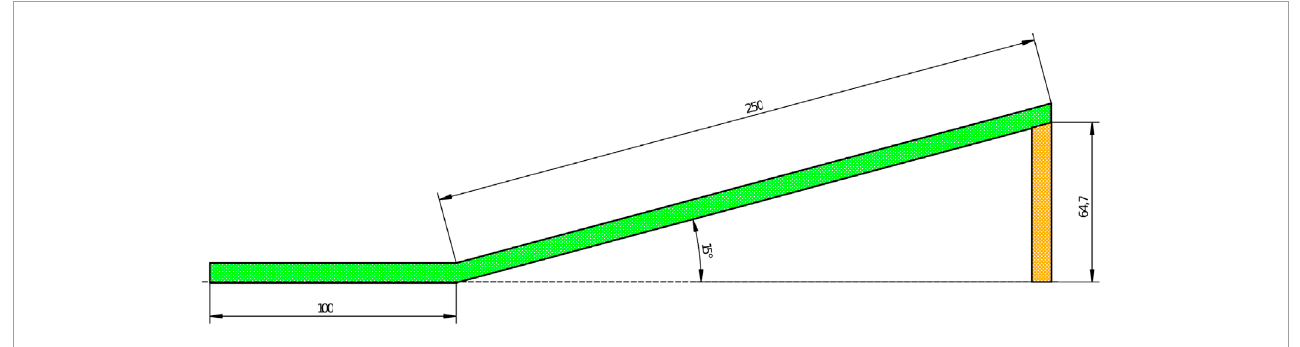
FIGURE 1 Ramp dimensions (in centimeters).